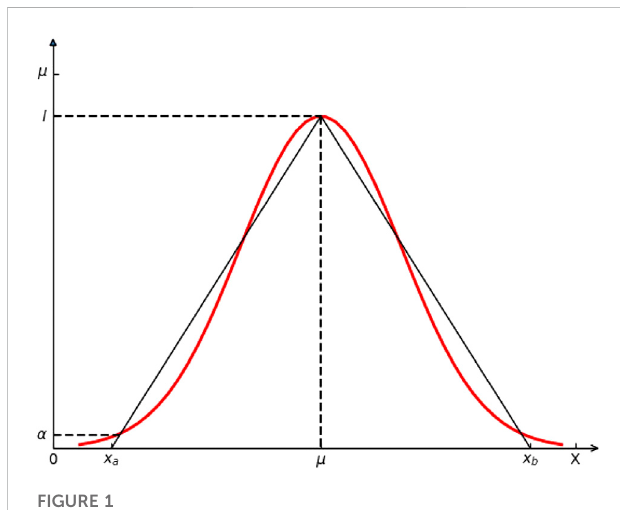
FIGURE 1 Normally distributed fuzzy numbers and triangular fuzzy numbers.